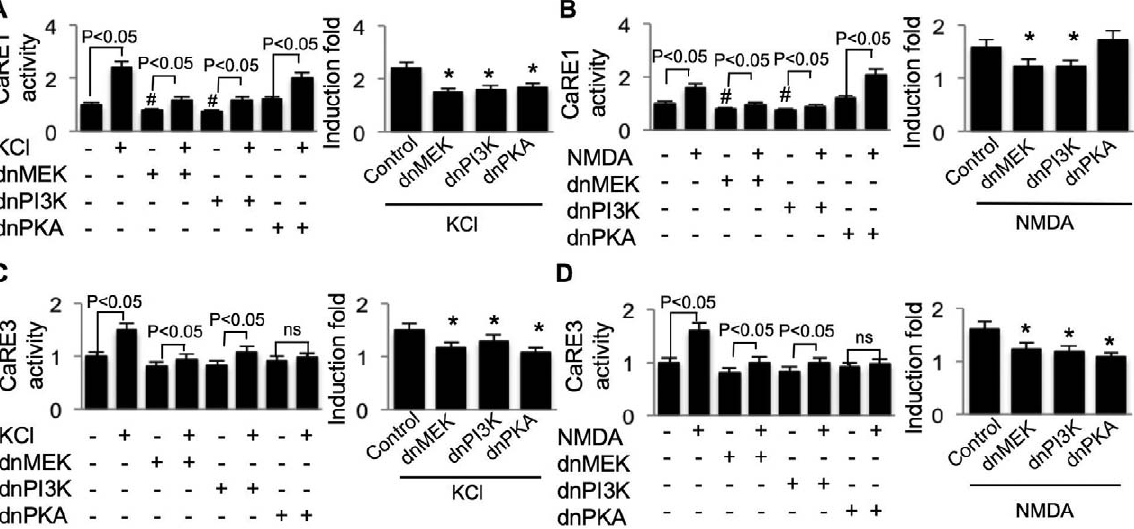
Figure 5. Regulation of Ca 2 + -stimulated CaRE1 and CaRE3 activity by MEK, PI3K, and PKA. DIV 9 cortical neurons were transfected with CaRE1-Luc (A and B) or CaRE3-Luc (C and D) plus TK-pRL and dominant negative MEK, PI3K, and PKA as indicated. For the normalization purpose, SV40-luciferase plus TK-pRL and dominant negative MEK, PI3K and PKA were transfected into different sets of neurons. On DIV 11, neurons were treated with 50 mM KCl (A and C) or 20 m M NMDA (B and D). Dual luciferase assay was performed after the six-hour incubation with KCl or NMDA. After normalized to Renilla luciferase activity, CaRE1- or CaRE-3 activity was further normalized to SV40 activity, and expressed as relative values. In the left panels, ‘‘ # ’’ indicates significant difference between neurons expressing dn construct and the naı¨ve neurons without dn construct; ns indicates no statistical difference. In the right panels, the effect of dn construct on KCl- or NMDA-stimulated transcription was normalized to the dn construct-only group (*: statistically different to that of the KCl- or NMDA-stimulated transcription in neurons not expressing any dn construct). For all experiments in this figure, data were collected from 12 independent preparations for each experiment.